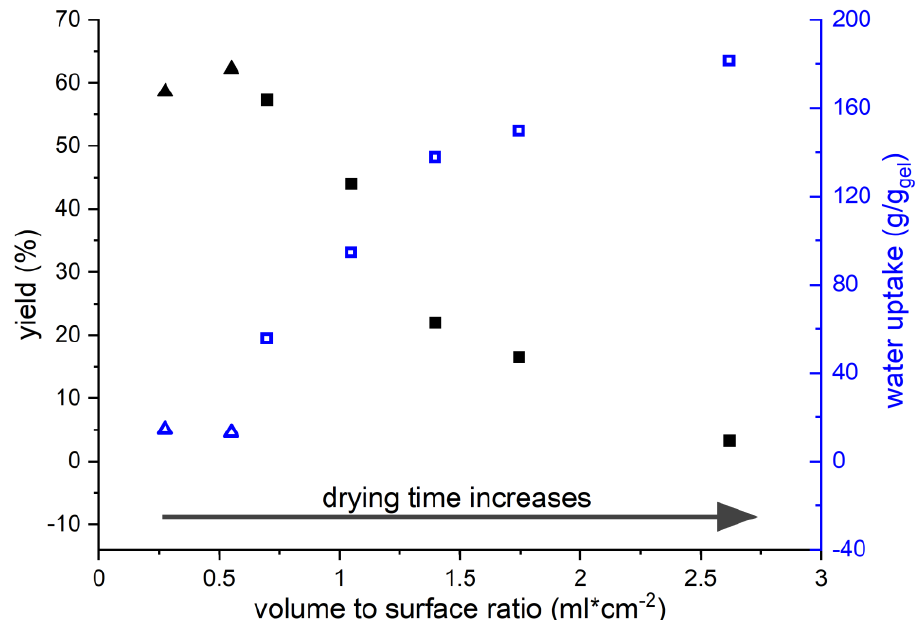
Figure 4. Trends in gel yield (solid) and water uptake (open) using different volume to surface ratios for the drying of KG5-02 solutions. Triangles refer to gels prepared in a wide, shallow petri dish (d × h = 136 mm × 20 mm) and squares to gels prepared in narrow, high cylindrical vial (d × h = 27 mm × 430 mm).